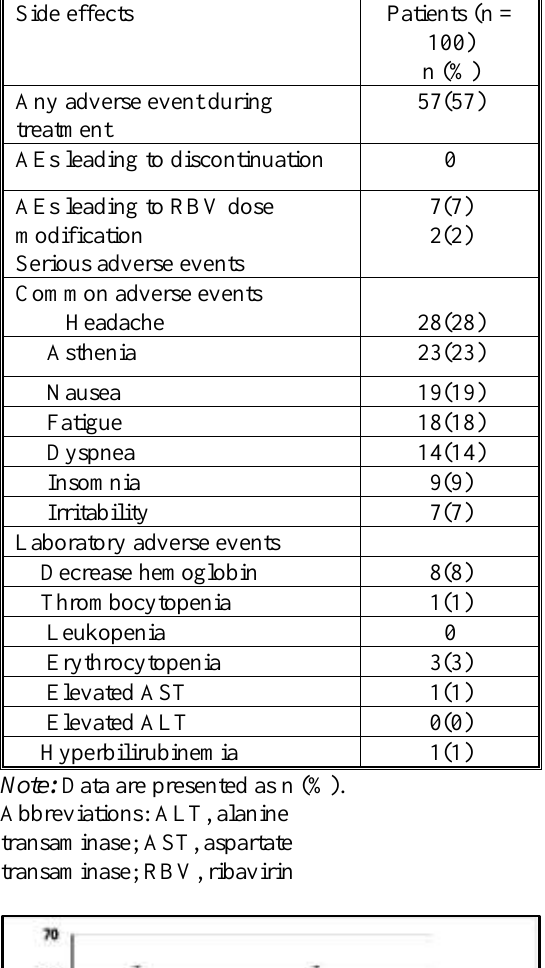
Table 3. Adverse events (AEs) and laboratory abnormalities in overall patients .